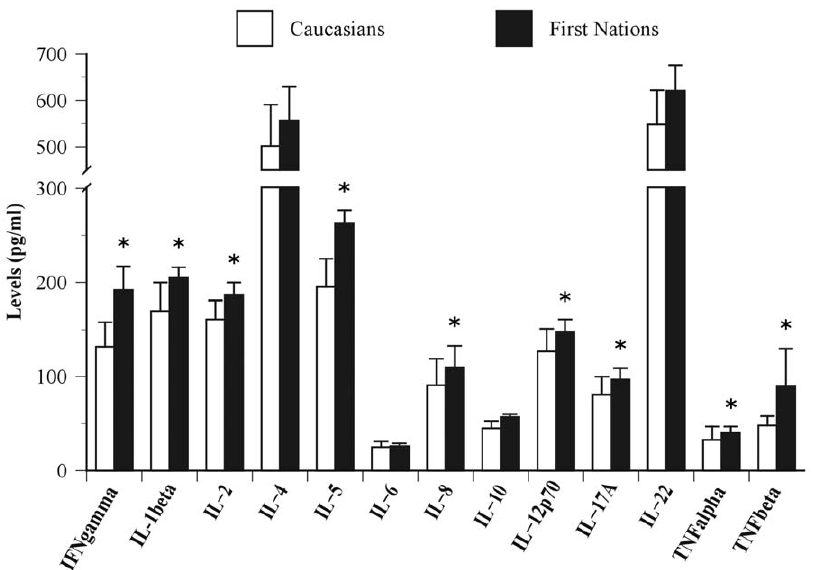
Figure 2. Plasma cytokine levels of Caucasians from the southern province of Que´bec (Canada) and First Nations from northern remote communities of Ontario (Canada). Significant difference between groups at * p , 0.05. doi:10.1371/journal.pone.0039931.g002 r 2 = 0.055) and community (community 1) (t= 2 2.59, df= 65, p = 0.01; partial r 2 = 0.085) showing significantly statistical detect- able contributions to model fit.